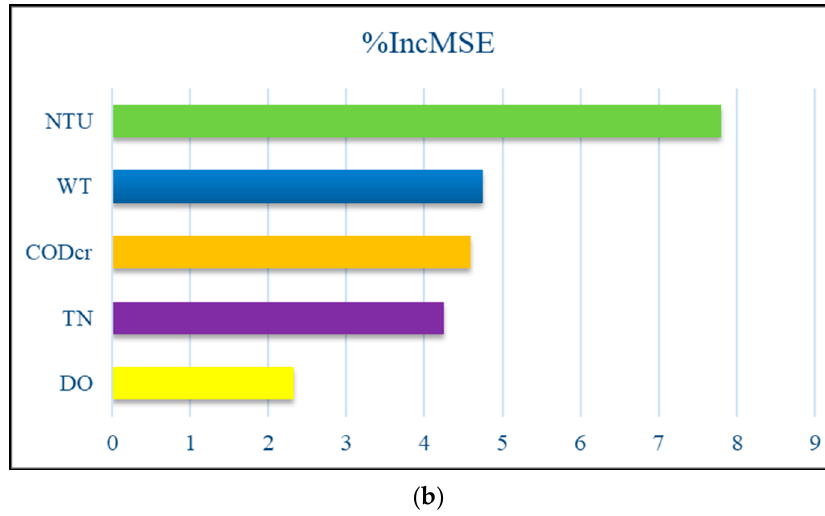
Figure 6. Environmental factors ranked in descending order of importance based on ( a ) %IncMSE and ( b ) major environmental drivers of phytoplankton abundance in spring.